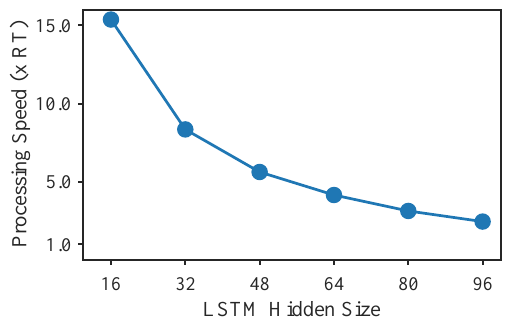
Figure 10. The processing speeds of RNN models plotted against the LSTM hidden